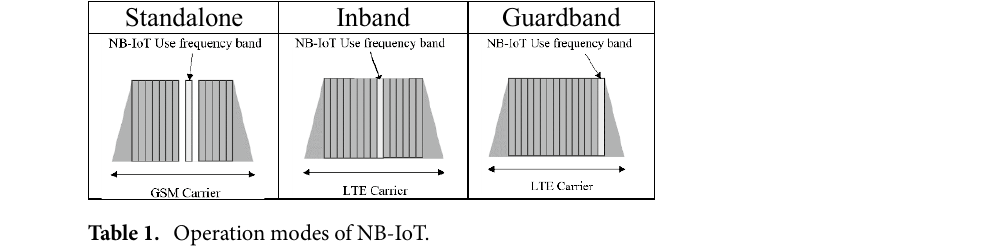
Table 1. Operation modes of